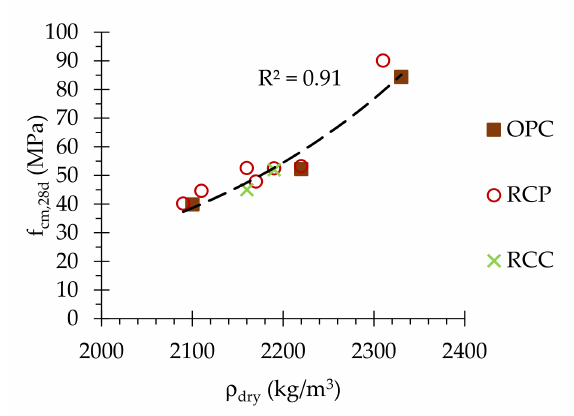
Figure 14. Compressive strength, f cm , as a function of dry density, ρ dry , at 28